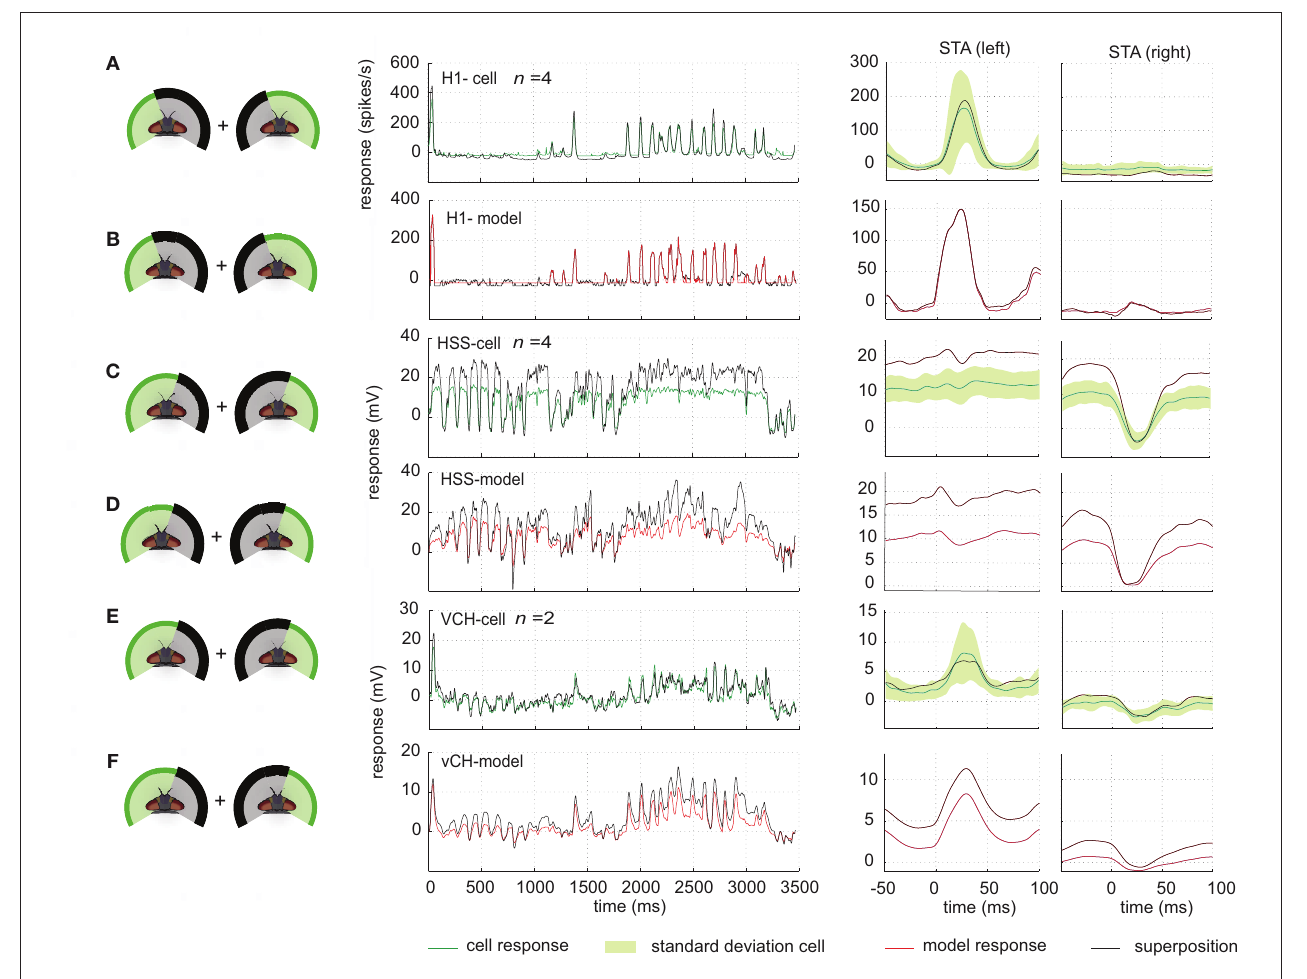
displayed with same color code. The standard deviation of the responses to full stimulation is shown in light green. (B) Model H1 response to full stimulation (red) and response superposition (black) plotted against time. Right: corresponding STAs with the same color code as used in (A) . (C,D) Comparison shown for the right HSS-cell (C) and the model HSS (D) with color codes as above. (e,F) Comparison shown for the right vCH-cell (e) and the model vCH (F)